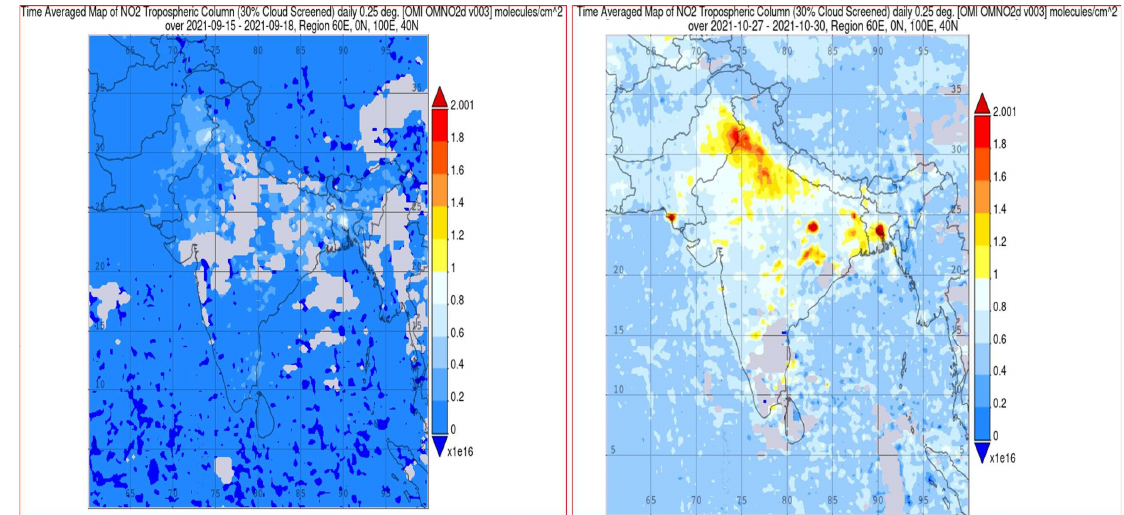
Figure 3. NO 2 Tropospheric column during the pre-harvest and post-harvest periods. CO is regarded as a tracer of biomass burning and long-range transport [26,36]. During the pre-harvest period, the hourly average concentration of CO ranged from 225.0 to 998.6 ppb with an average concentration of 709.4 ± 481.7 ppb; during the post-harvest period, it ranged from 856.8 to 1980.5 ppb, with an average concentration of 1498.5 ± 1077.5 ppb (Figure S1). CO concentrations showed statistically significant differences ( p = 0.01)